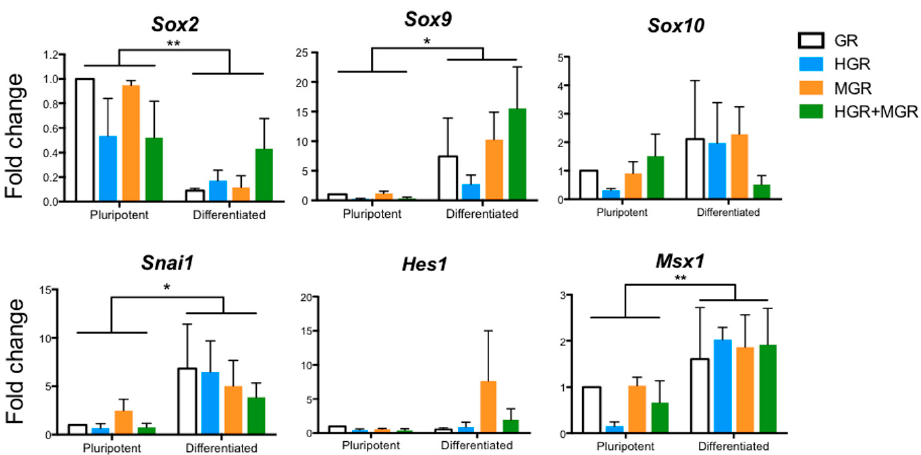
Figure 6. Induction of neural crest markers in differentiated cells in the absence of dexamethasone. The transgenic cells were differentiated into neural crest derivatives over 10 days. The expression of several markers was measured using end point RT-PCR. The expression of each gene was normalized to β - actin expression, and the fold change was determined relative to the levels found in pluripotent GR cells. mean ± SEM. Statistical analysis was conducted via two-way ANOVA followed by Tukey’s multiple comparison test to establish differences between pluripotent and differentiated cells from 3 independent experiments. * p < 0.01; ** p < 0.001. No differences were found between the four cell lines when compared at in the pluripotent state or after differentiated conditions, indicating that the significant differences are caused by the differentiation protocol.